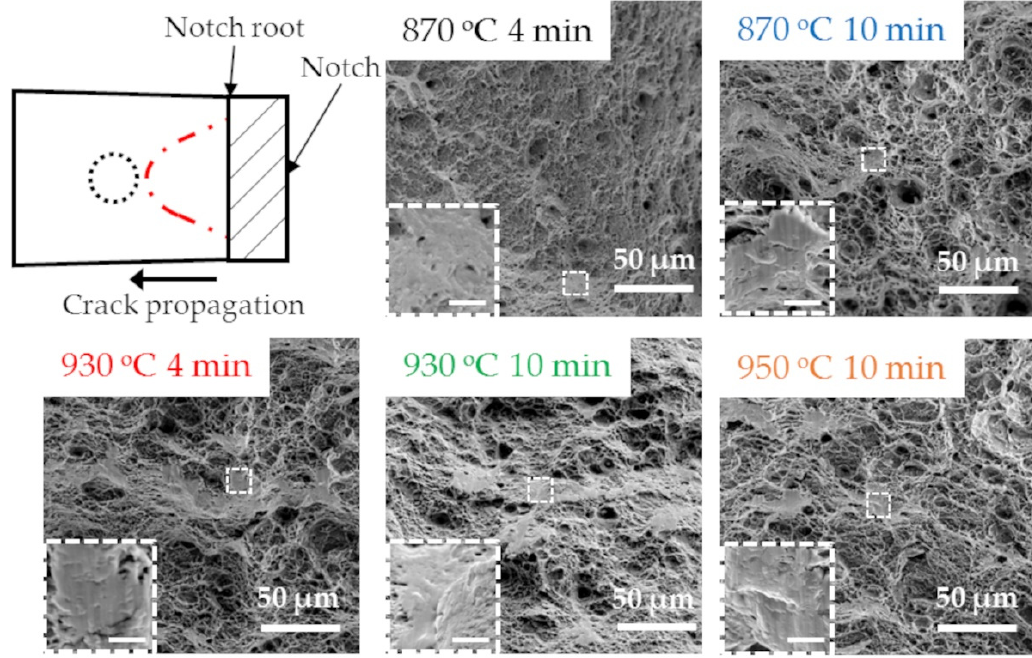
Figure 12. SE-SEM images taken from a location that lies outside the thumbnail shaped region on the fracture surface near the initial notch root of the single-edge notch specimens (as shown in the schematic) of the five heat-treated martensitic steel. The inset in the SEM images show the zoomed view of a representative quasi-cleavage region marked with a dashed box in the respective images. The scale bar for all the insets is 5 μm . The loading direction is into the viewed plane.